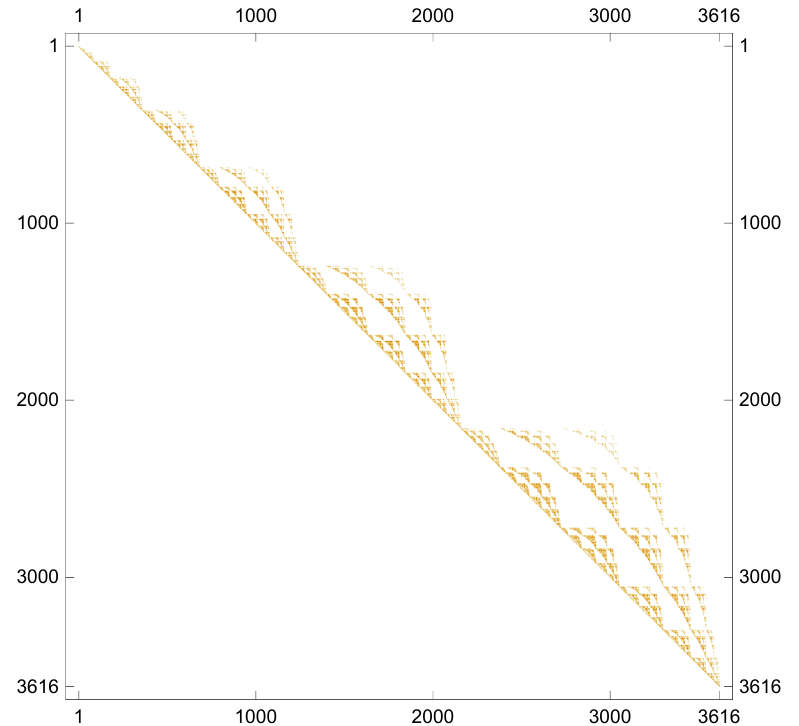
Figure 2 . Structure of the measure matrix M y , x for sl (4) length L = 3 spin chain with all 3616 SoV states up to SoV charge N = 10 . All non-zero elements denoted by a yellow pixel. Within each fixed SoV charge block the states x and y are ordered lexicographically according to the words ( n 1 , 1 , n 2 , 1 , n 1 , 2 , n 2 , 2 , n 1 , 3 , n 2 , 3 ) . The matrix is upper triangular and has a fractal-like self-repetitive